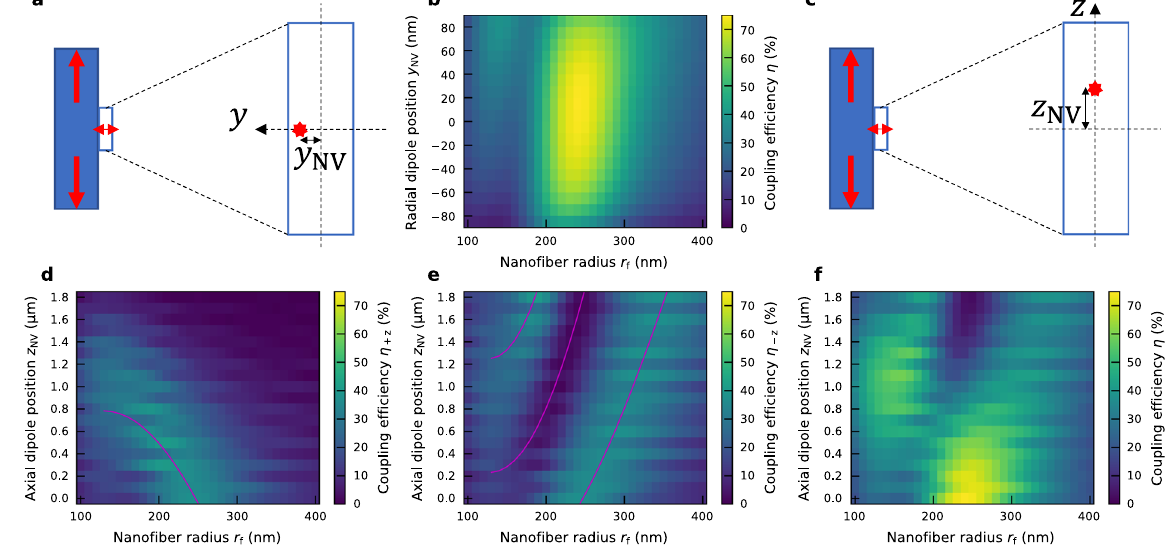
Figure 4. Dependence of the coupling efficiency on the dipole positions. ( a ) Schematic of the radial dipole position y NV in the diamond nanowire. ( b ) Dependence of the coupling efficiency on the radial dipole position y NV from the radial center of the diamond nanowire and the nanofiber radius r f for the case of the nanowire radius r d = 85 nm and the nanowire length L d = 3.6 μ m with radial polarization. ( c ) Schematic of the axial dipole position z NV in the diamond nanowire. ( d – f ) Dependence of the coupling efficiency on the axial dipole position z NV from the axial center of the diamond nanowire to the + z direction and the nanofiber radius r f for the same geometry as that of ( b ). ( d ), ( e ), and ( f ) represent the coupling efficiencies for + z fiber end, − z fiber end, and the sum of both fiber ends, respectively. The magenta solid lines in ( d ) and ( e ) represent the beat effect against the change of the axial dipole position z NV for the + z and − z directions, respectively.